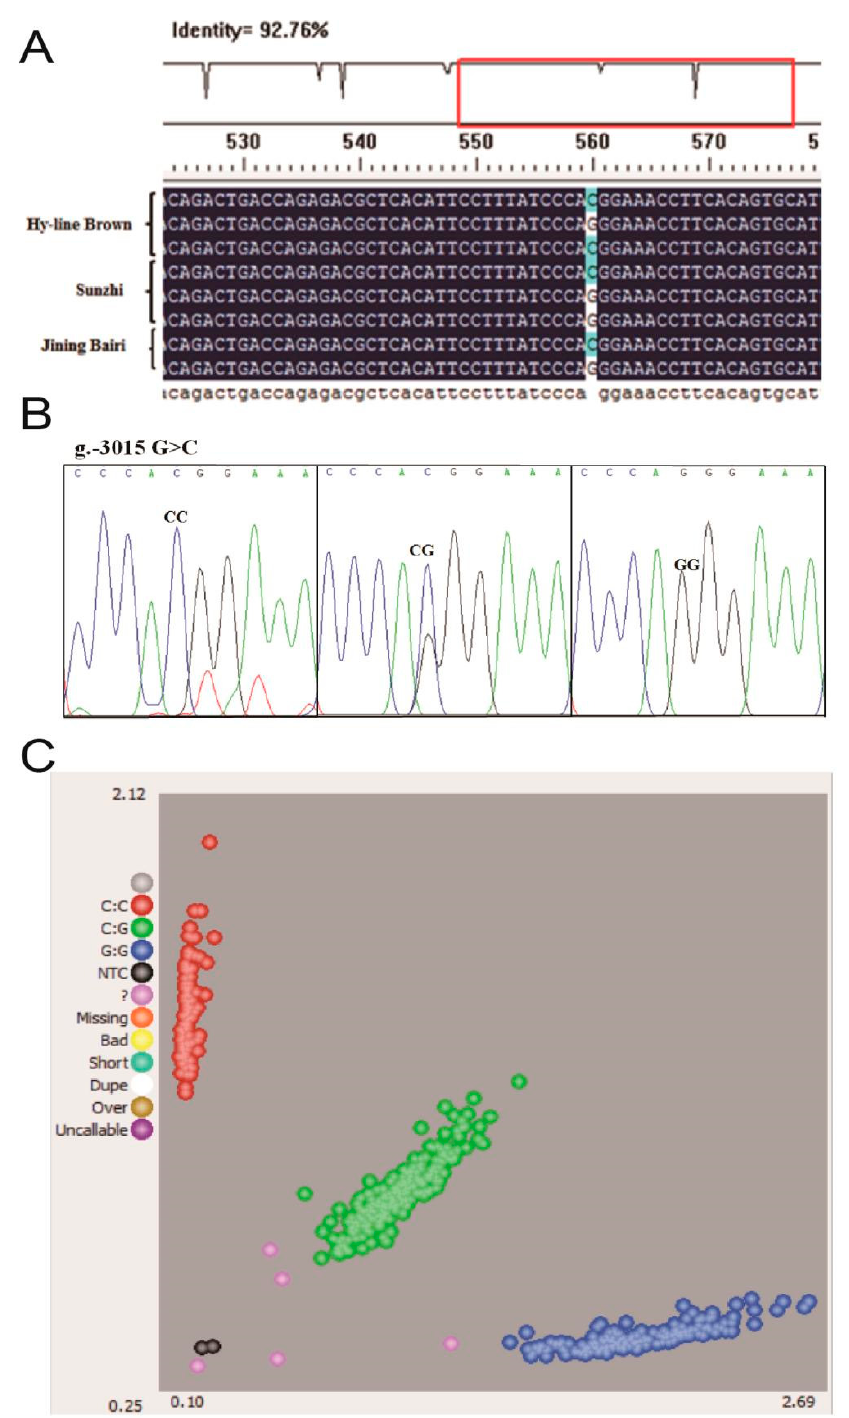
Figure 2. All schemes follow the same formatting. Polymorphisms in the critical promoter region of chicken WNT4 gene. ( A ) Sequencing alignment of SNP site in Hy-line Brown hens, Jining Bairi hens and Sunzhi hens; one SNP (g. − 3015) was detected. ( B ) Genotyping of the SNP (g. − 3015) site and three genotypes. ( C ) Genotyping in the Jining Bairi population ( n = 539) using the KASP method. The number of successful genotyping individuals was 539. NTC (black point), no template controls. These are wells that do not contain any template DNA and will therefore not generate any fluorescent signal. Unused (pink point), samples that have not been assigned a genotyping call because they did not generate a consistent signal or failed to